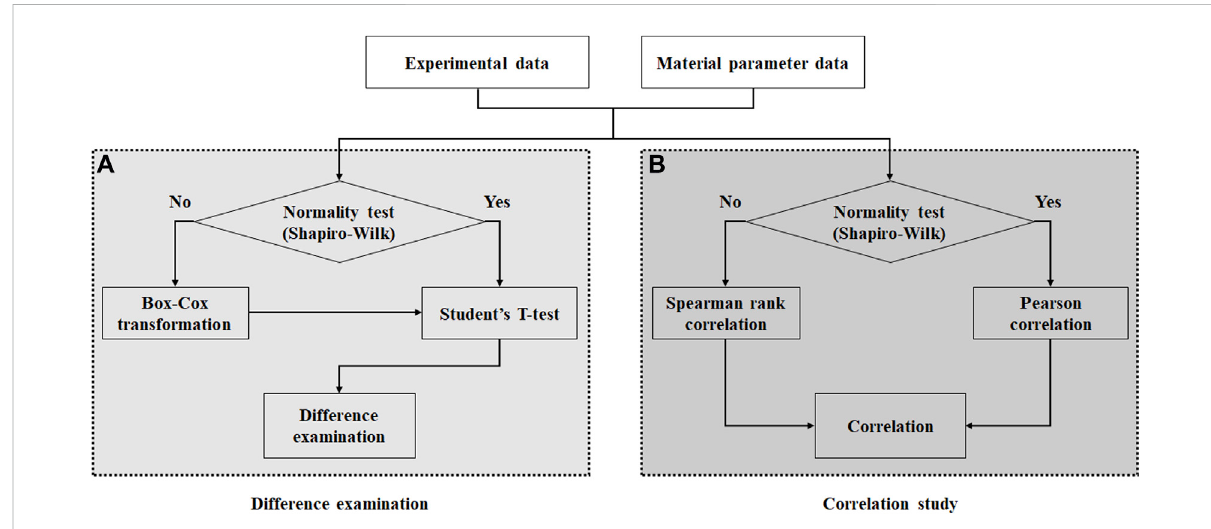
FIGURE 2 Flow chart showing procedures for (A) difference examination and (B) correlation